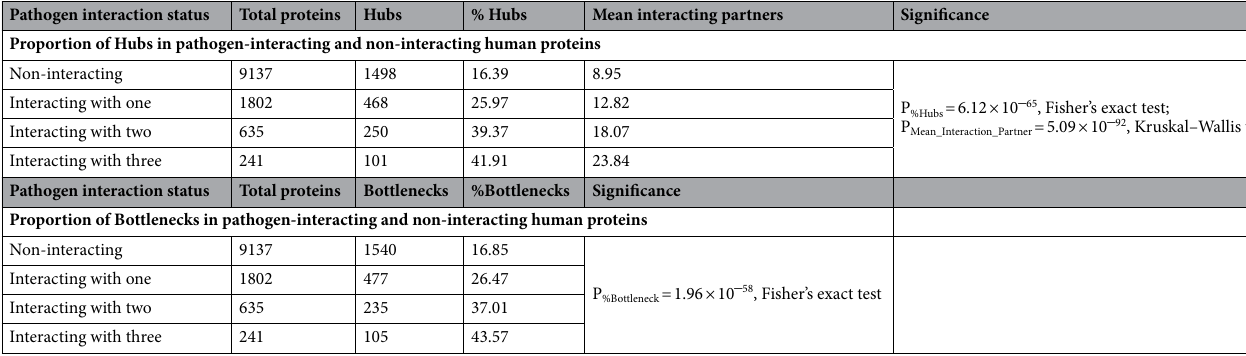
Table 1. Proportion of hubs and bottlenecks in human proteins based on their interactions with bacterial pathogens.